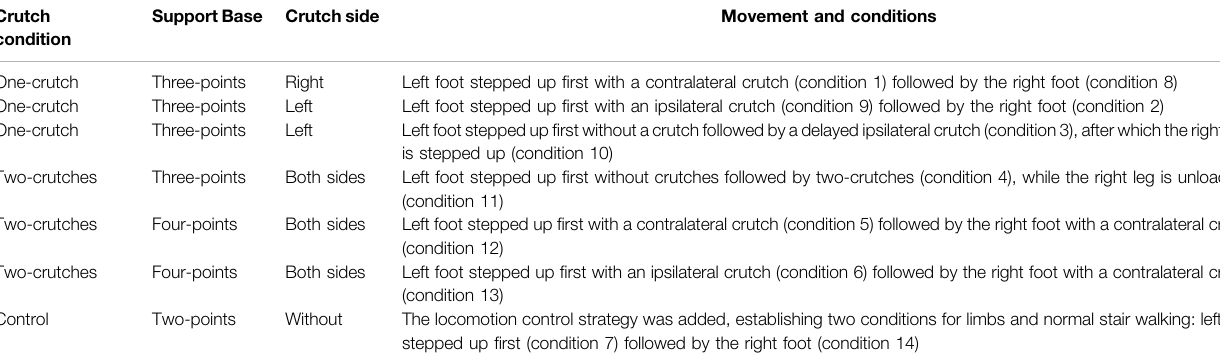
TABLE 1 | Details of the different conditions for crutch locomotion during stair ascending. Crutch Support Base Crutch side condition